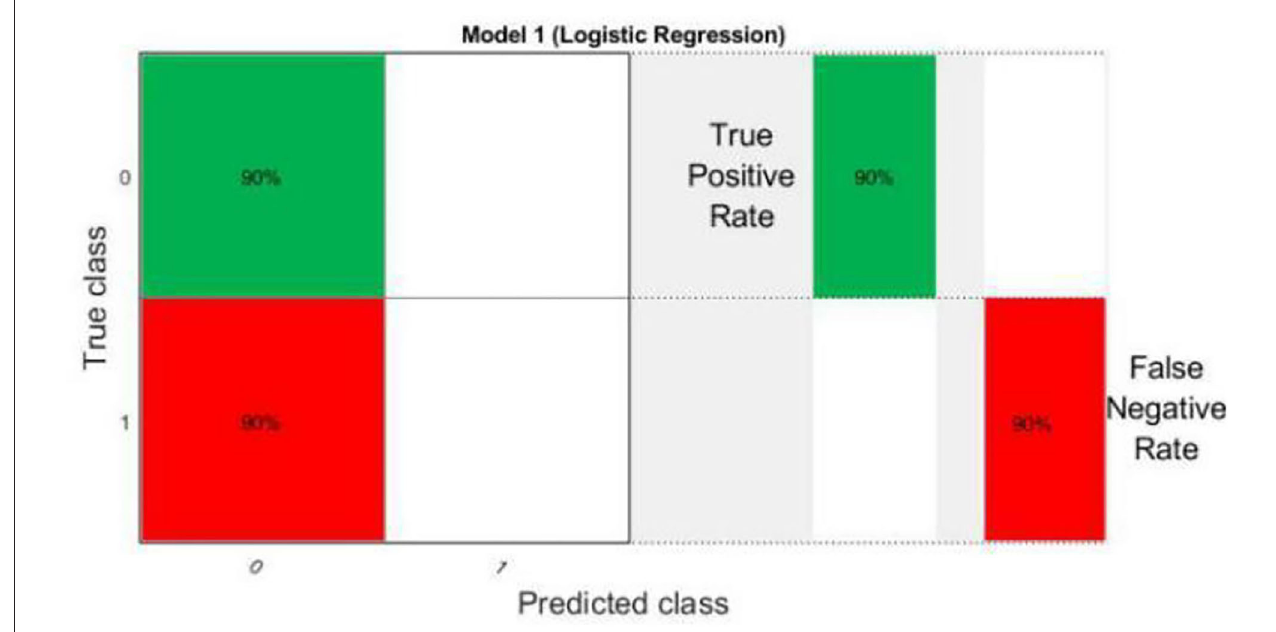
FIGURE 9 | Confusion matrix plot from logistic